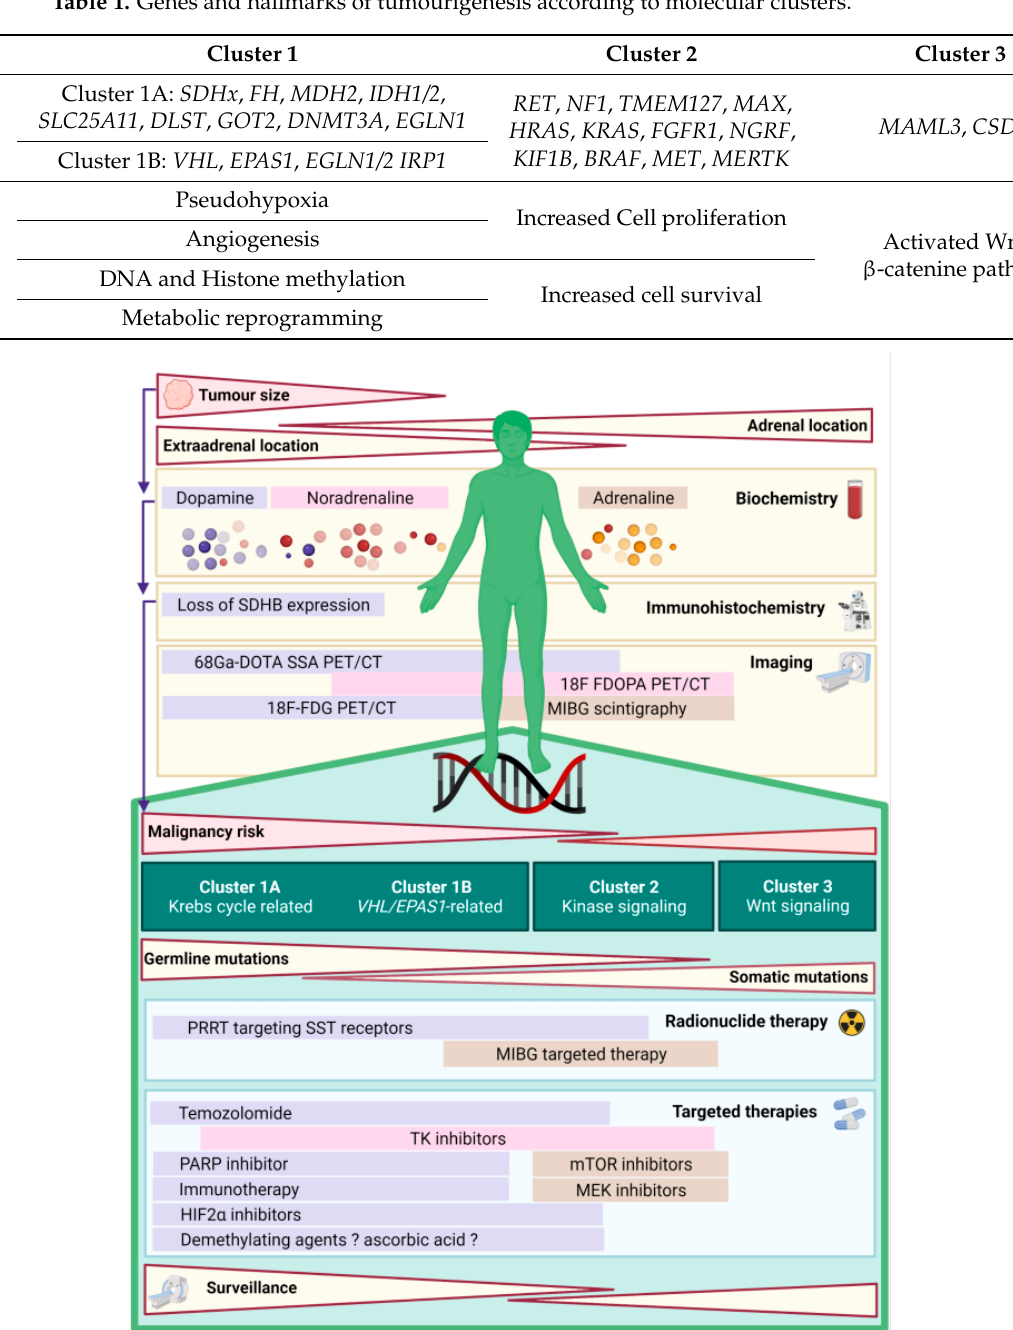
Figure 1. provides an overview of how molecular classification can guide a personalized approach to PPGL patients. PARP: poly-(ADP)-ribose polymerase, mTOR: mechanistic Target of Rapamycin, MEK: mitogen-activated protein kinase kinase (MAP2K), TK: tyrosine kinase, MIBG: metaiodobenzylguanidine, PRRT: peptide receptor radionuclide therapy, SST: somatostatin